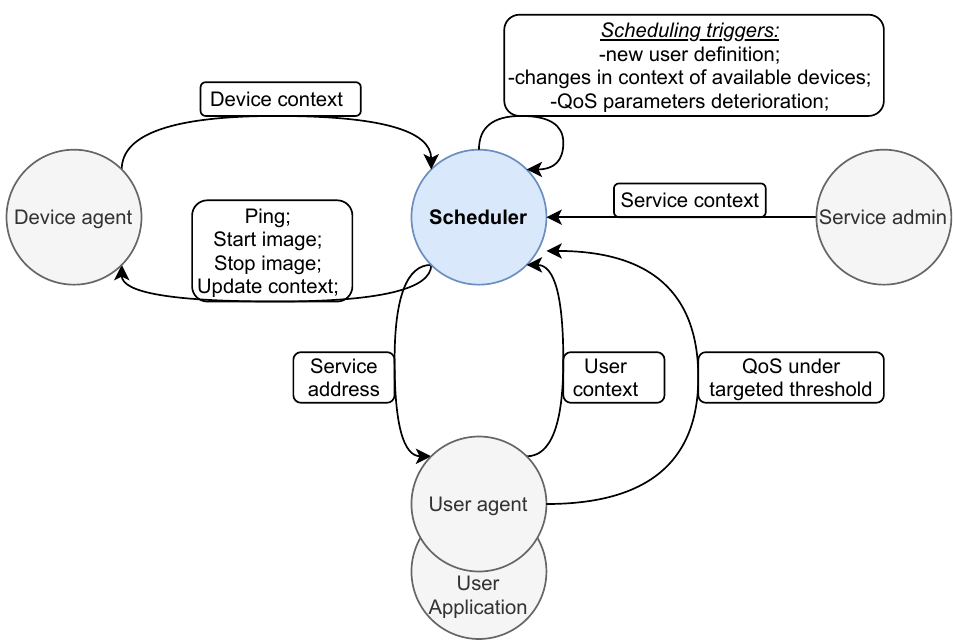
Figure 2. High-level formal model of the scheduling